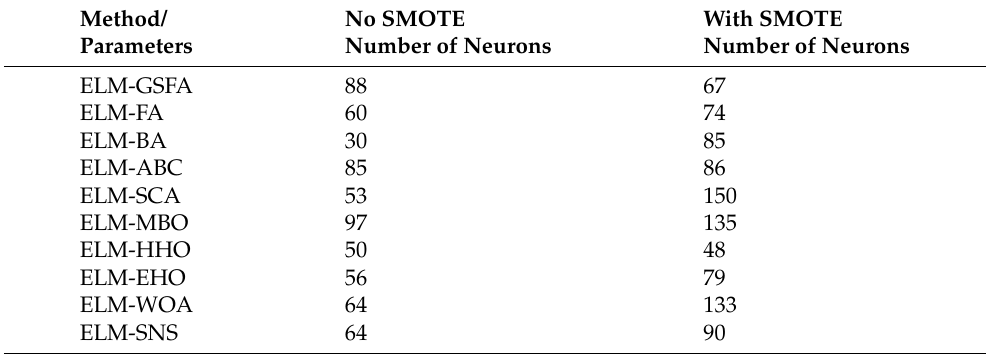
Table 15. Best ELM number of neurons in hidden layer obtained by the analyzed algorithms.